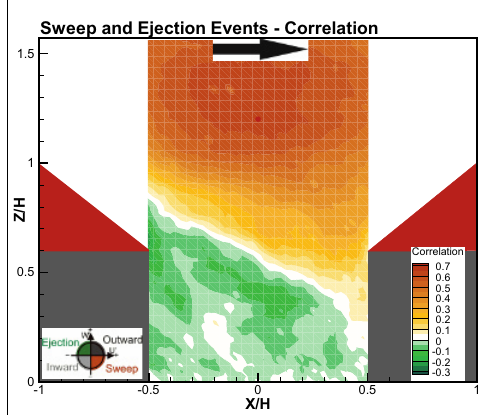
Fig. 8: Correlation between time-series created by insert- ing sweep (with true negative sign) and ejection (with pos- itive sign) in all points in the canyon and from time-series Figure